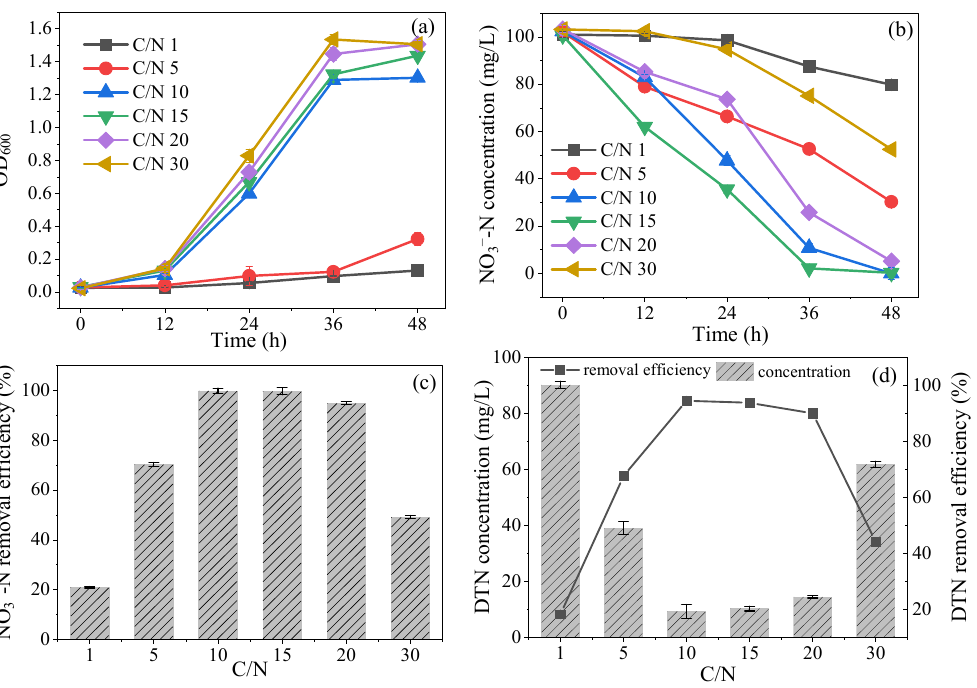
Figure 5. Effect of C/N ratios on aerobic denitrification of strain 41. ( a ) Growth curves of strain 41; ( b ) variation of NO 3 − -N concentration; ( c ) removal efficiency of NO 3 − -N; ( d ) characteristics of DTN removal.